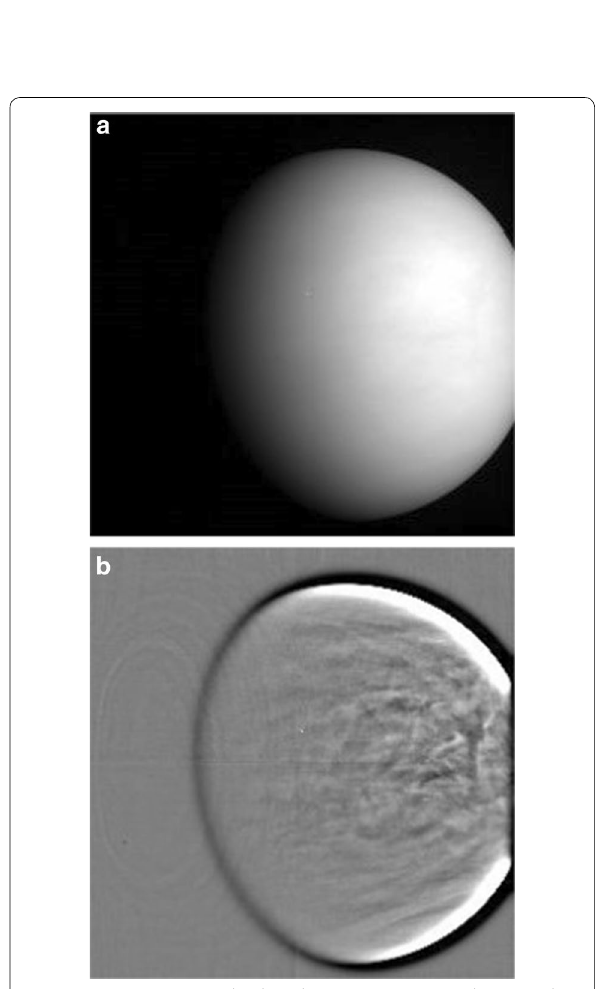
Fig. 15 a A 0.90‑μm Level 2 dayside image at 04:51 on the same day as the Bow event in Fig. 14 at a distance of 68,000 km with a sub‑ spacecraft latitude of 7° and longitude of 96°. b A high‑pass‑filtered − image of Fig. 15a